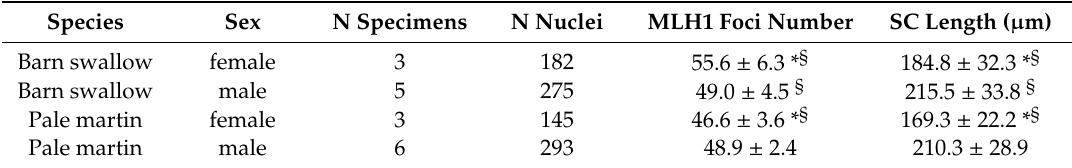
Table 1. Number of MLH1 foci at autosomes and total length of autosomal SC (m ± S.D.) in female and male barn swallows and pale martins.